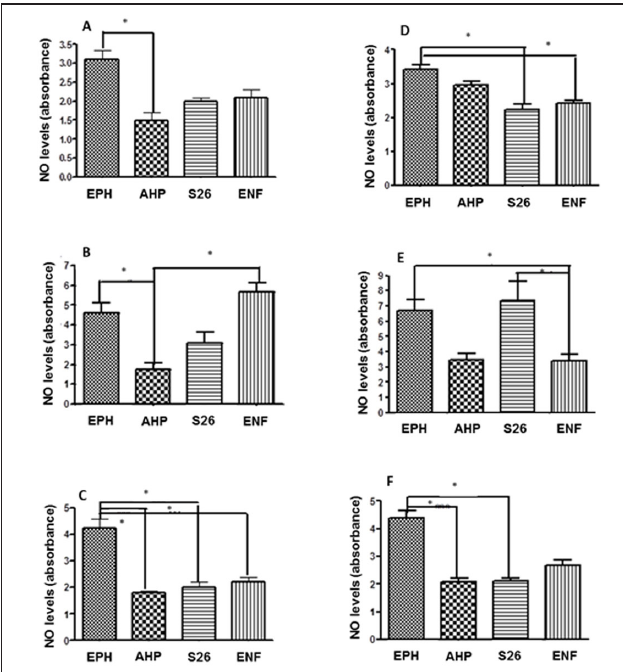
Fig. 2: Comparison of nitric oxide levels released by fibroblasts (A, B, C) and macrophages (D, E, F) cultivated with Epiphany (EPH), AH Plus (AHP), Sealer 26 (S26) and Endofill (ENF) at different periods of time. *Statistically significant differences between